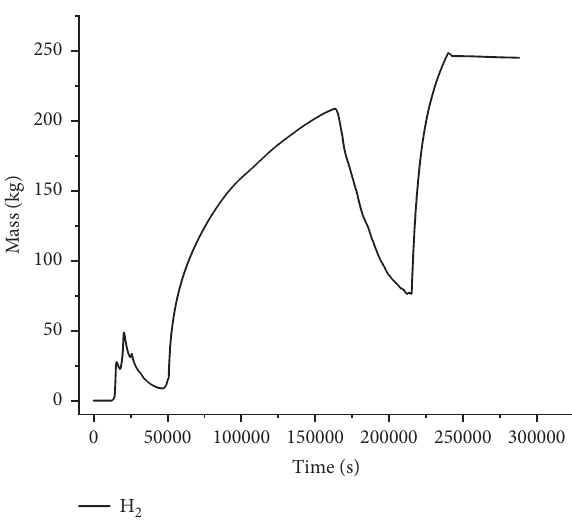
Figure 5: Hydrogen release from containment over time.